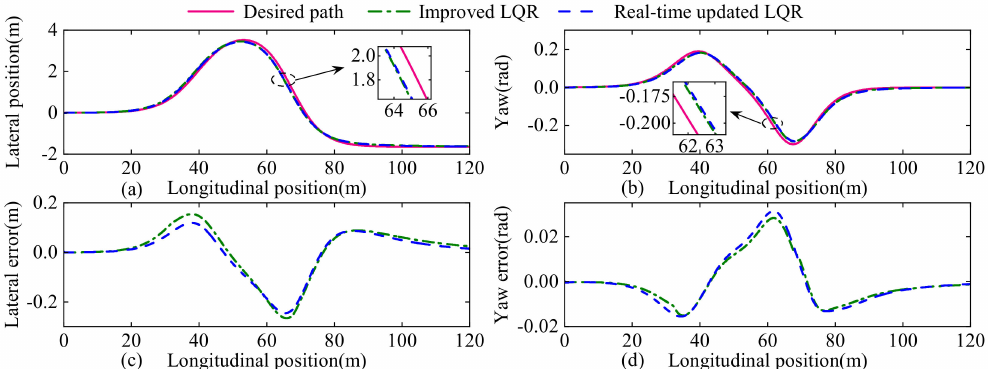
Figure 24. Performance comparison between the improved LQR and the real-time updated LQR under the velocity of 15 m/s: ( a ) lateral position; ( b ) yaw; ( c ) lateral error; ( d ) yaw error.